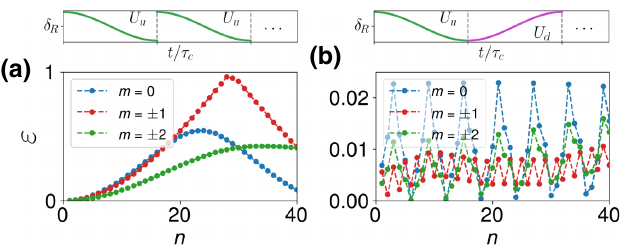
FIG. 5. Numerical results of spin leakage ε = ε ( n ) for the m , (cid:2) m (left) and chirp-alternating ˜ U ( n ) (right) controls traditional ˜ U ( n ) uu ud as a function of pulse number n . The peak Raman pulse area is A R = 9 π . The corresponding two-photon detuning profiles are illustrated on top of (a),(b). Additional parameters for the simulations are according to the experimental Sec. III C.